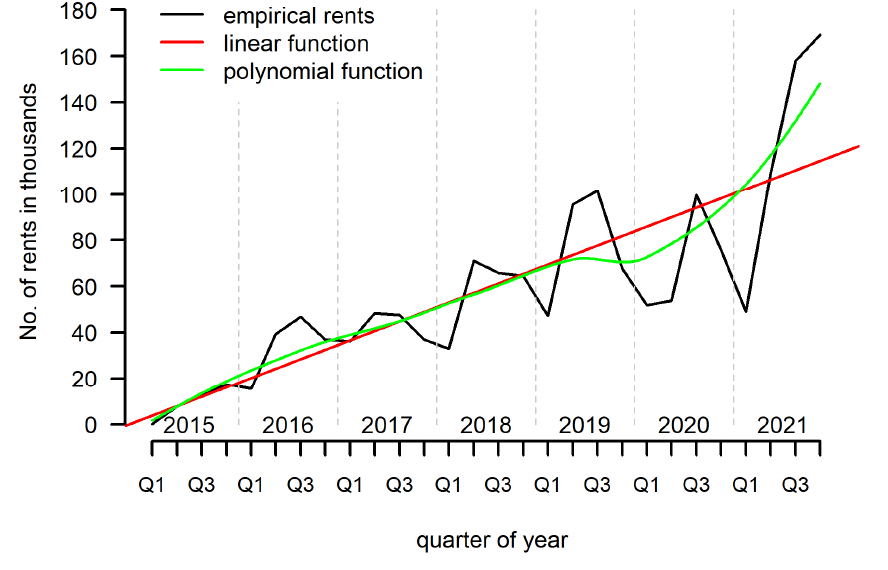
Figure 2. Quarterly development of the absolute number of rents.